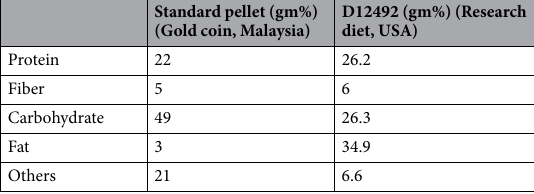
Table 2. Major components of the standard diet and